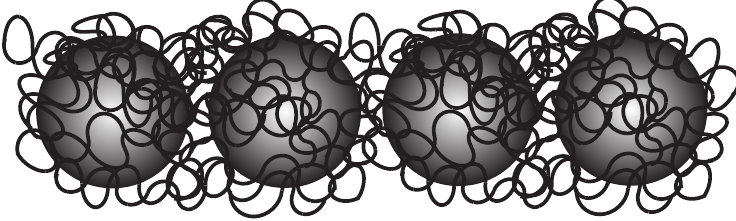
Figure 5. Super-paramagnetic colloids bridged by a polymer chain, forming flexible fibers.